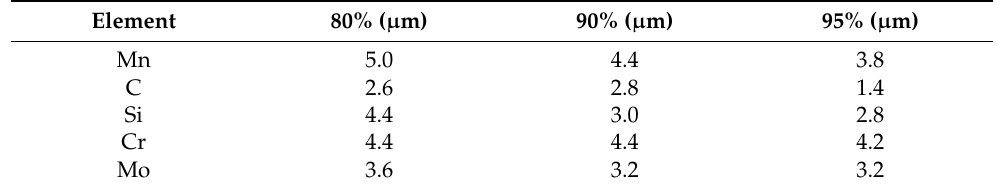
Table 3. The element diffusion distances of multilayer TWIP/40Si2CrMo steels with different hot rolling reductions.